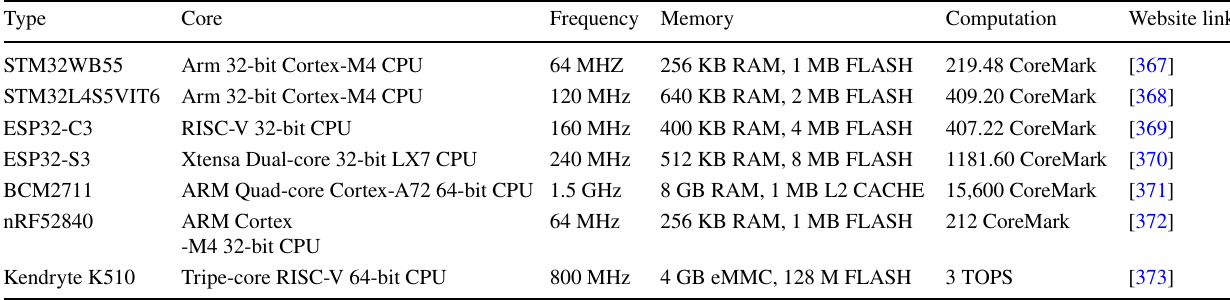
Table 5 Typical chips supporting algorithm implantation